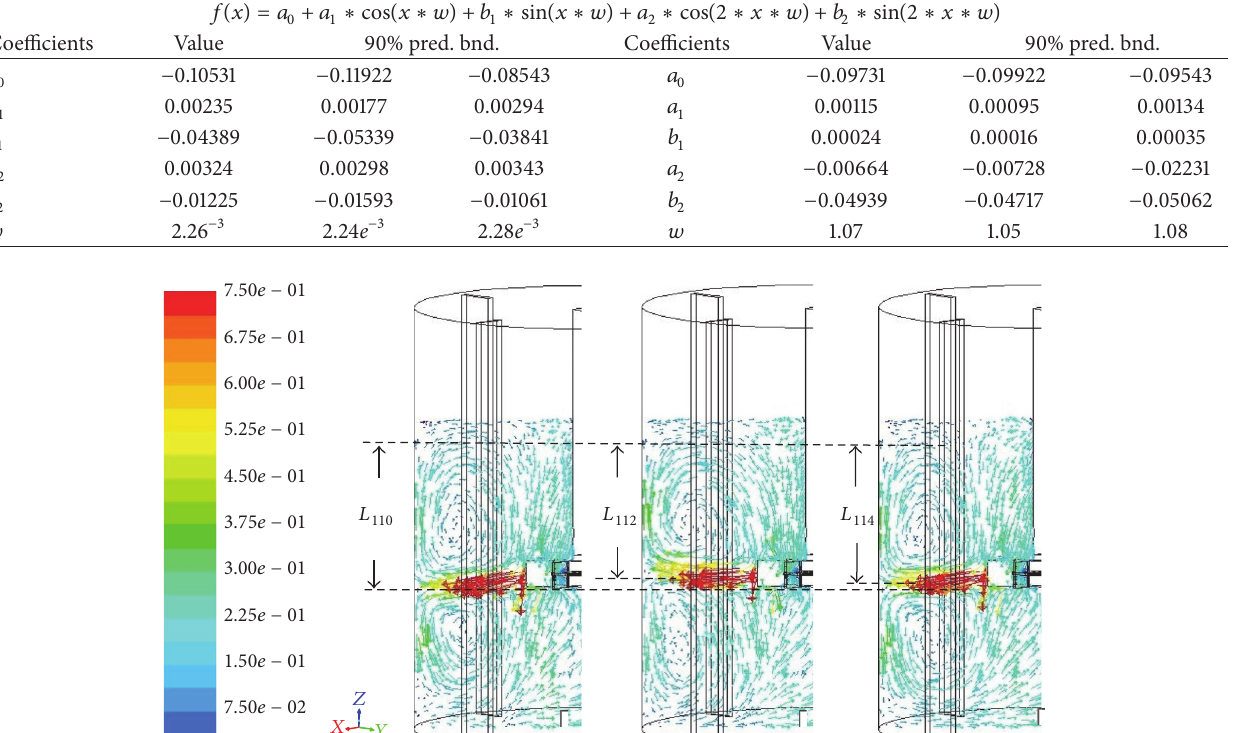
Table 3: Fourier fitting parameters of experiment (left) and simulation (right).